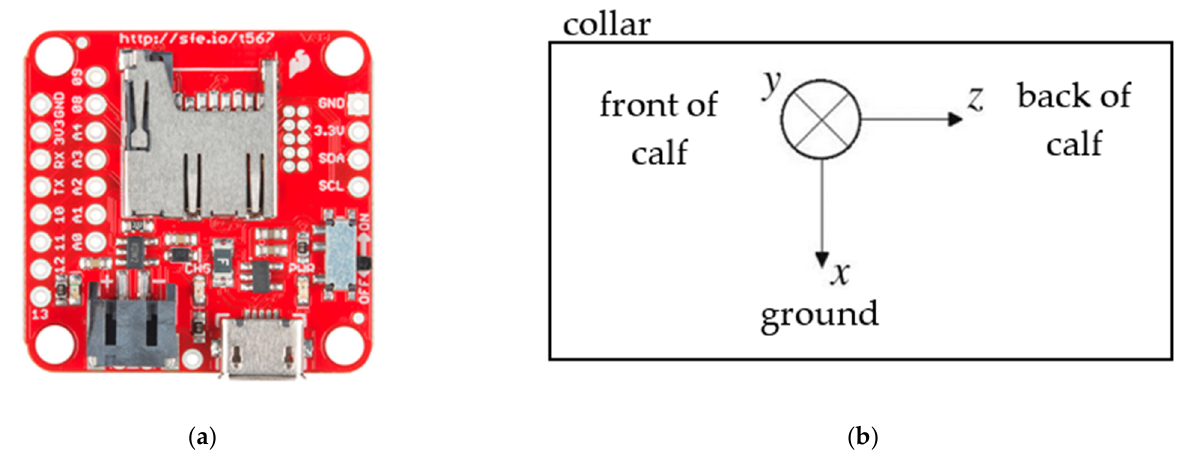
Figure 1. Photo of sensor used ( a ) sensor orientation on the collar ( b ).